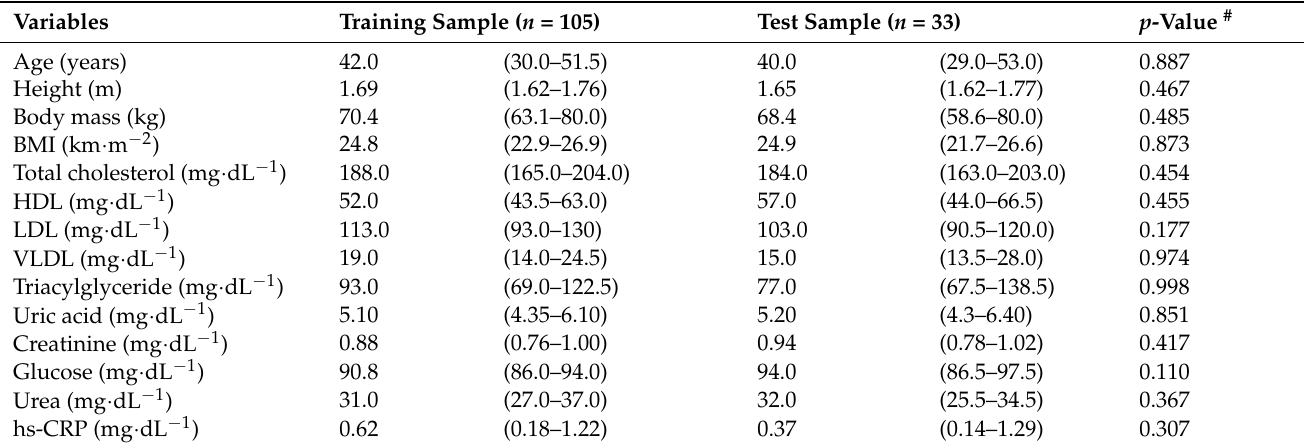
Table 1. Age, physical, and clinical characteristics of the participants ( n = 138). Data are median (interquartile